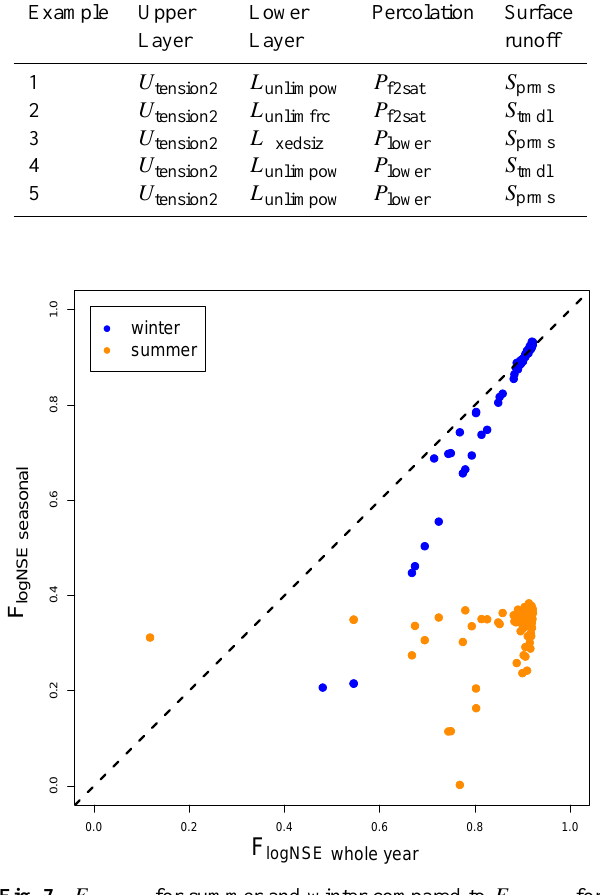
Fig. 7. F logNSE for summer and winter compared to F logNSE for the whole year; the 8 models with F logNSE < 0 are not shown.